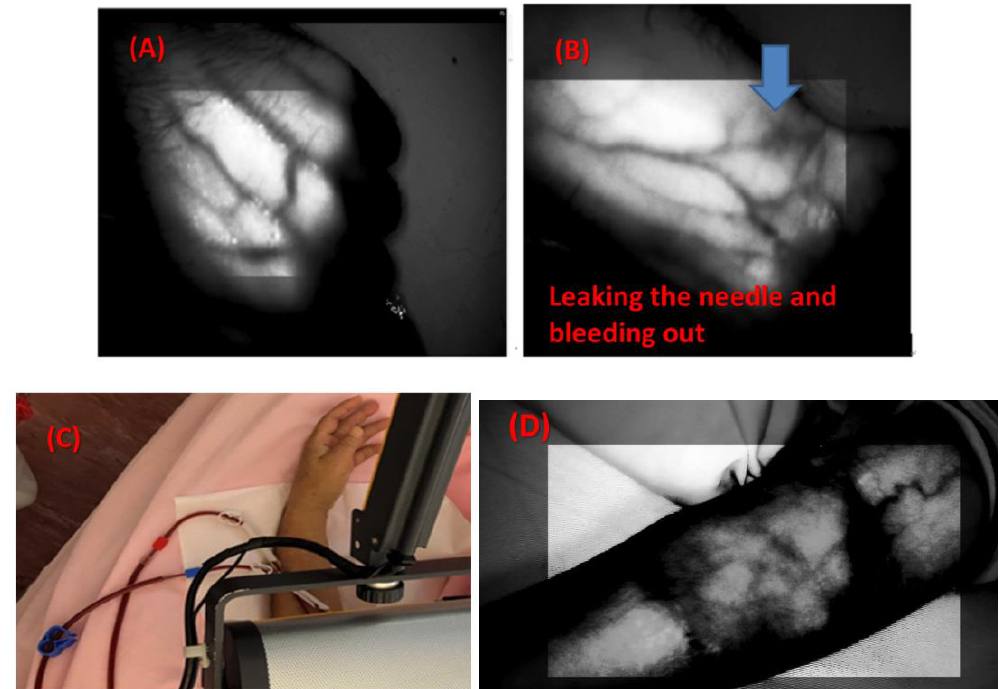
Figure 9. Observing arteriovenous vascular images and therapeutic tissue repair: ( A ) near-infrared source, very clear image of blood vessels, which can be observed in a local range, ( B ) leaking needle and bleeding out, ( C ) in the hemodialysis process, the near-infrared imaging system can be used to simultaneously observe needle placement, needle leak, and blood seepage, and ( D ) during the hemodialysis process, with NIR image of a puncture in the affected area.